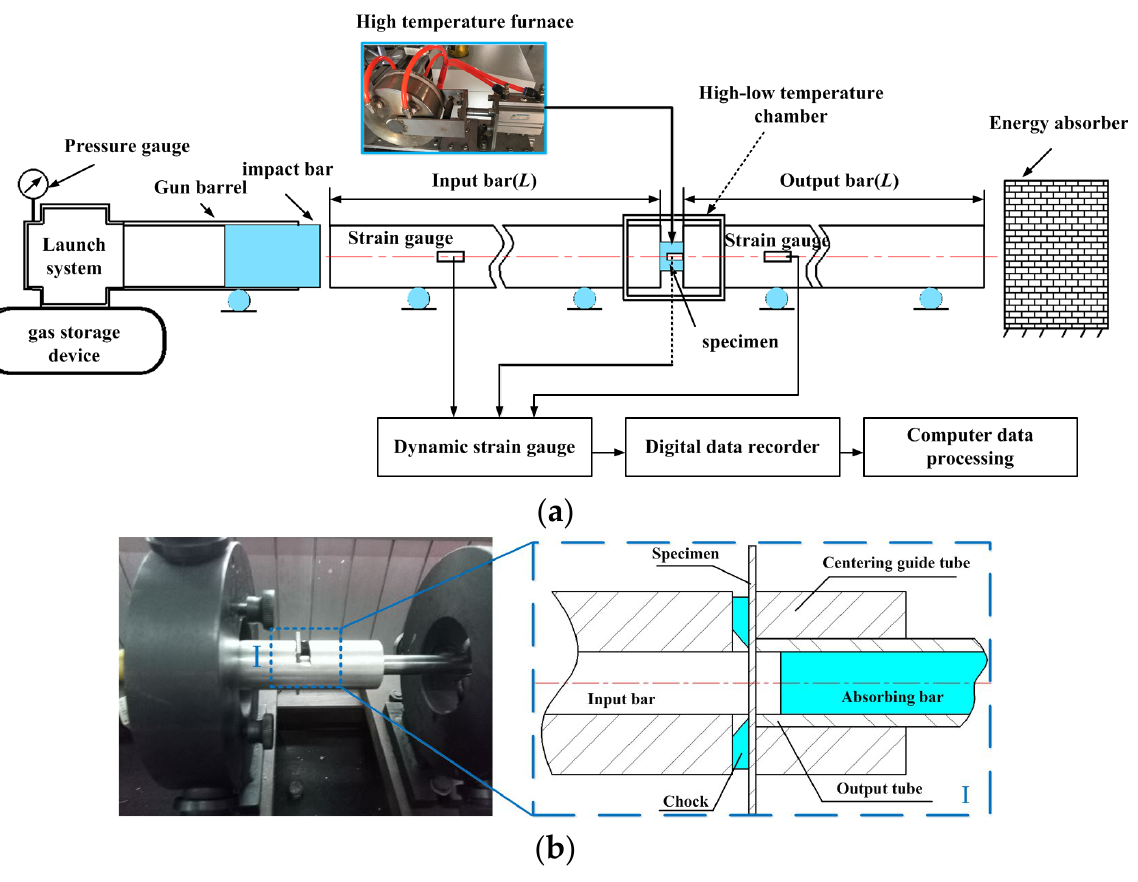
Figure 4. ( a ) SHPB device. ( b ) Dynamic “ Bar-Tube ” shearing device .